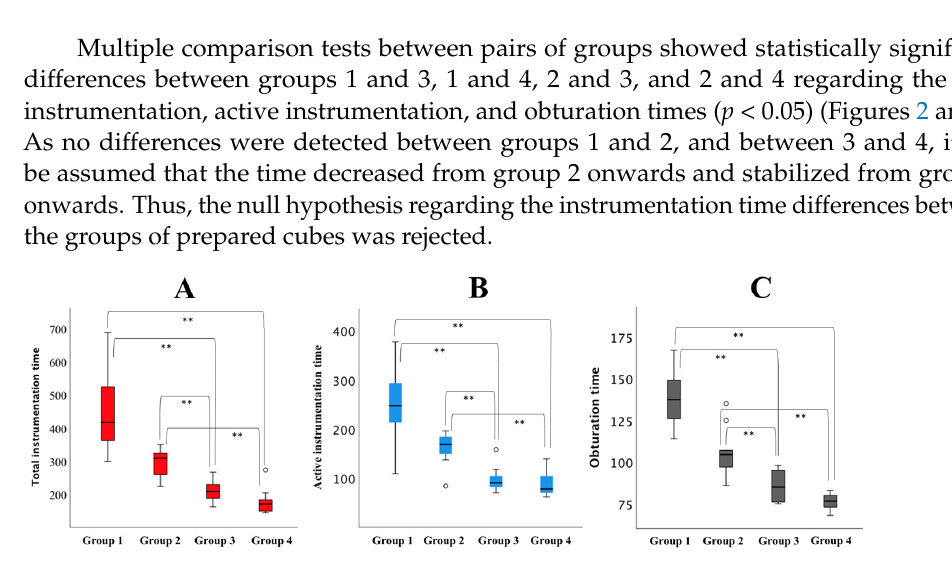
Figure 2. Multiple time comparisons between groups of 10 canals organized by preparation order.